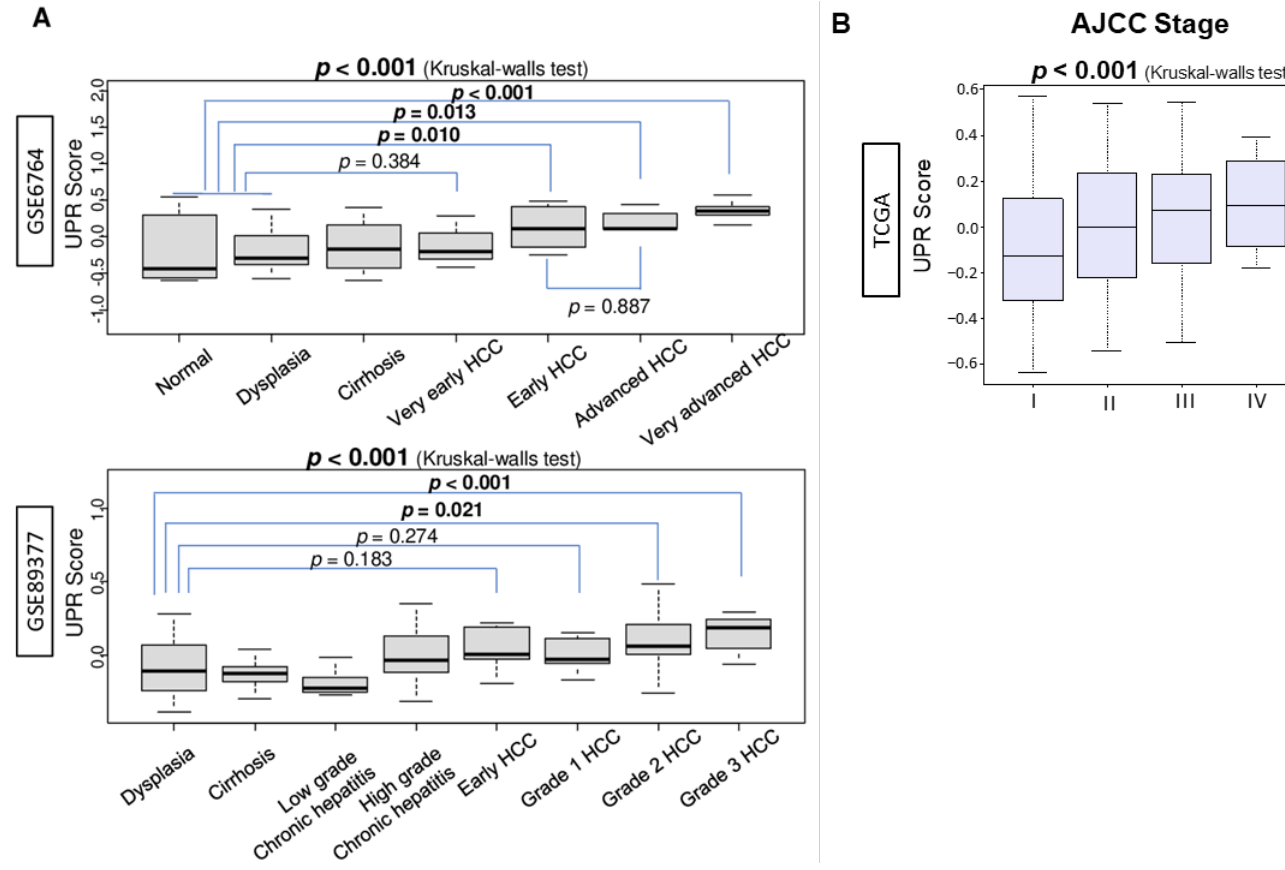
Figure 1. Association between Unfolded Protein Response (UPR) and hepatocarcinogenesis and progression. ( A ) Boxplots of the comparison of the unfolded protein response score by multistep hepatocarcinogenesis, including normal liver tissue ( n = 8), dysplasia ( n = 17), cirrhosis ( n = 13, very early hepatocellular carcinoma (HCC) ( n = 8), early HCC ( n = 10), advanced HCC ( n = 7), and very advanced HCC ( n = 10) defined by the GSE764 cohort ( n = 75); and dysplasia ( n = 35), cirrhosis ( n = 12), low-grade ( n = 8) and high-grade ( n = 12) chronic hepatitis, early HCC ( n = 5), and grades 1–3 ( n = 9, 12, and 14, respectively) of HCC defined by the GSE98377 cohort ( n = 107). The p -value of normal/dysplasia vs. each class of HCC analyzed using the Mann–Whitney U test in the GSE6764 cohort. The p -value of dysplasia vs. each class of HCC analyzed using the Mann–Whitney U test in the in GSE89377 cohort. The overall p -value was calculated using a Kruskal–Wallis test. ( B ) Boxplot of the comparison of the unfolded protein response and the American Joint Committee on Cancer (AJCC) stage I-III ( n = 166, 81, and 84, respectively) in the TCGA cohort. The overall p -value was calculated using a Kruskal–Wallis